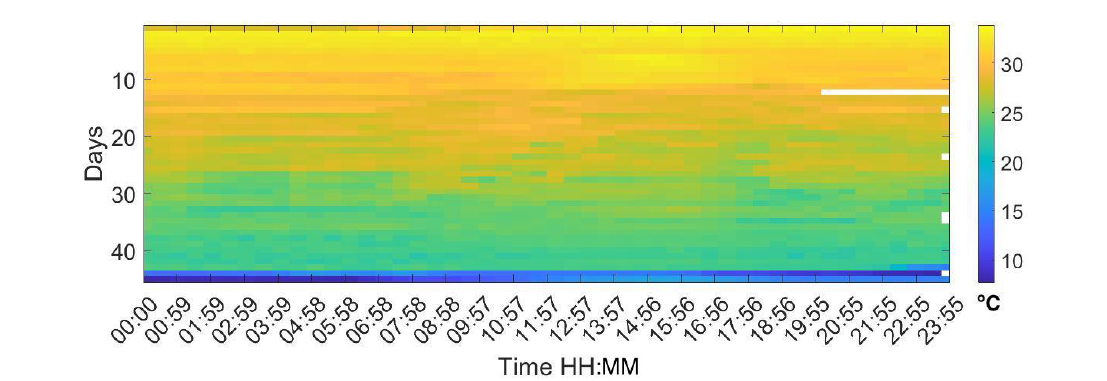
Figure 11. Map of the temperature values for each day of the campaign. The horizontal axis shows the hours of the day and night, displaying a value every 30 min, and the vertical axis shows the days of the cycle.